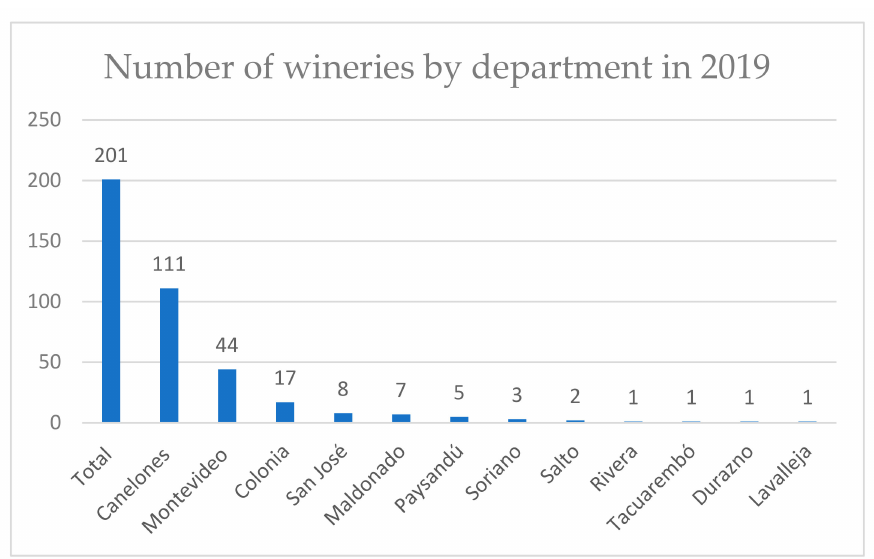
Figure 4. Number of wineries and dispersion by department. Source: INAVI [6,22].